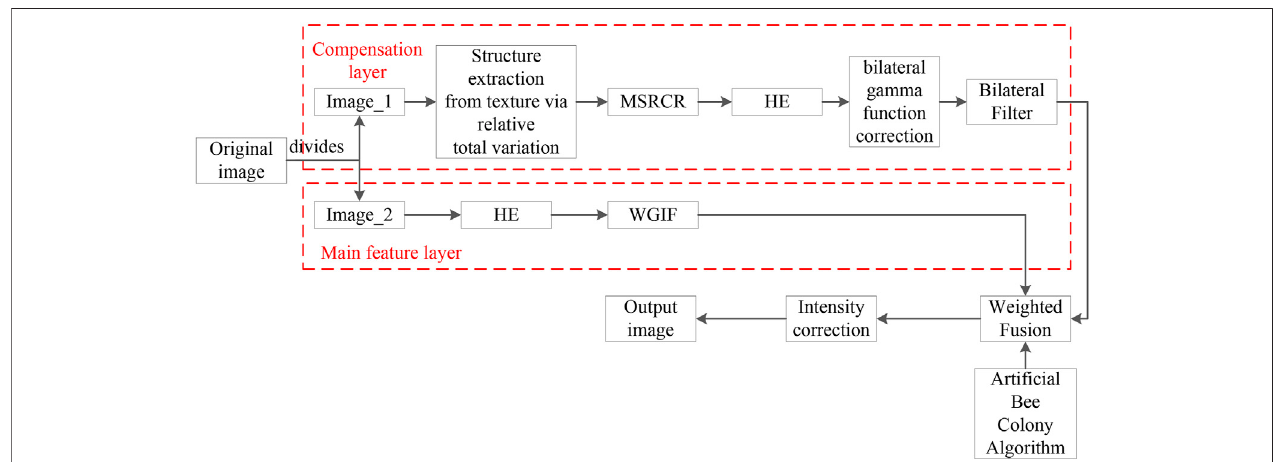
FIGURE 2 | Flowchart of the algorithm in this paper.